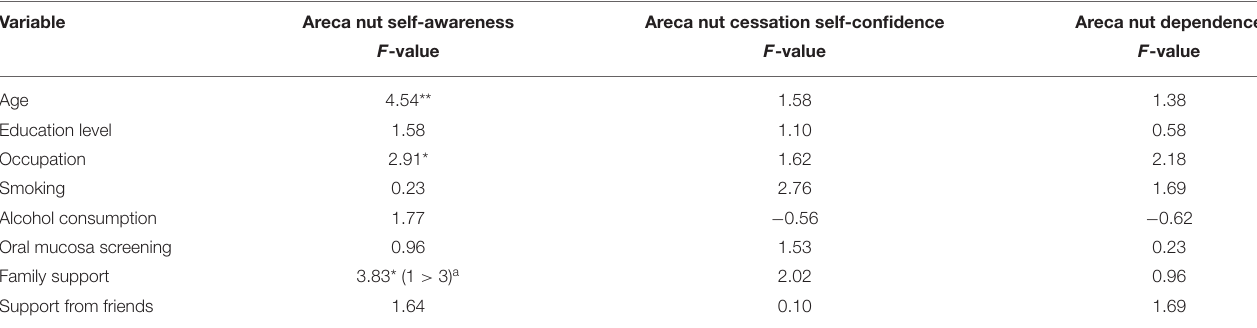
TABLE 3 | Analysis of correlation in areca nut self-awareness, areca nut cessation self-confidence, and areca nut dependence by various demographic variables ( n =